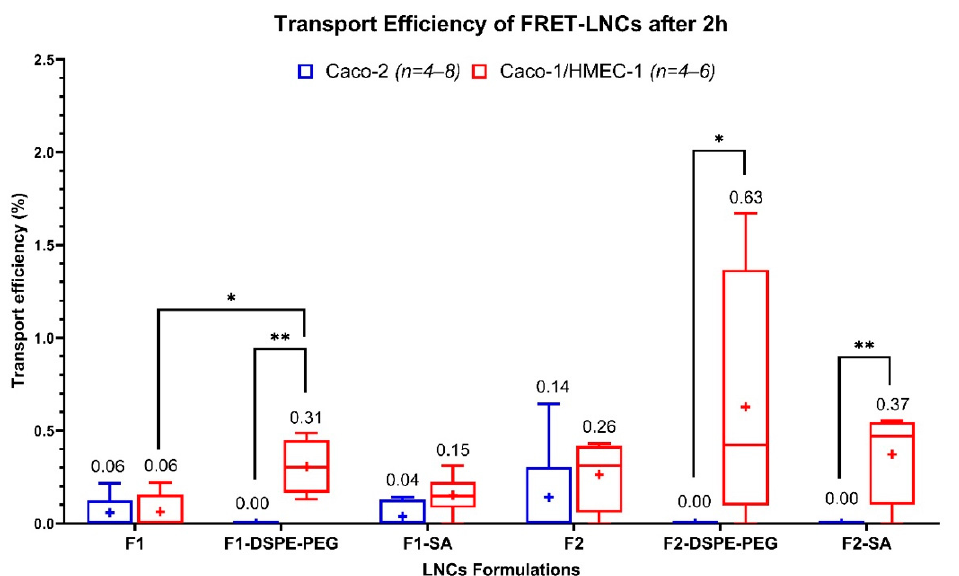
Figure 4. Transport efficiency of six FRET-LNCs formulations after 2 h in the Caco-2 model (blue, n = 4–8), and the Caco-2/HMEC-1 coculture model (red, n = 4–6). The (+) symbols represent the arithmetic mean, and the whiskers represent a 95% confidence interval (Kruskal–Wallis: * p ≤ 0.05, ** p ≤ 0.01).